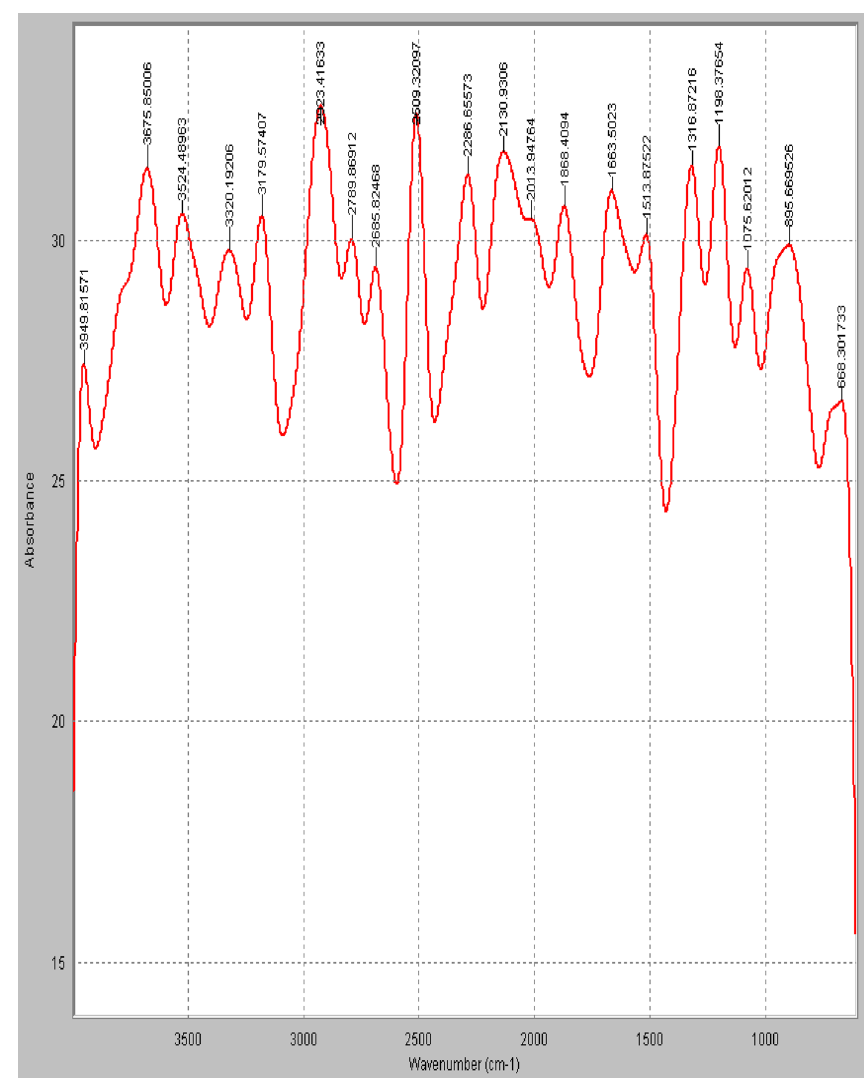
Fig. 4 FTIR spectrum analysis of OSA biosorbent before adsorption of